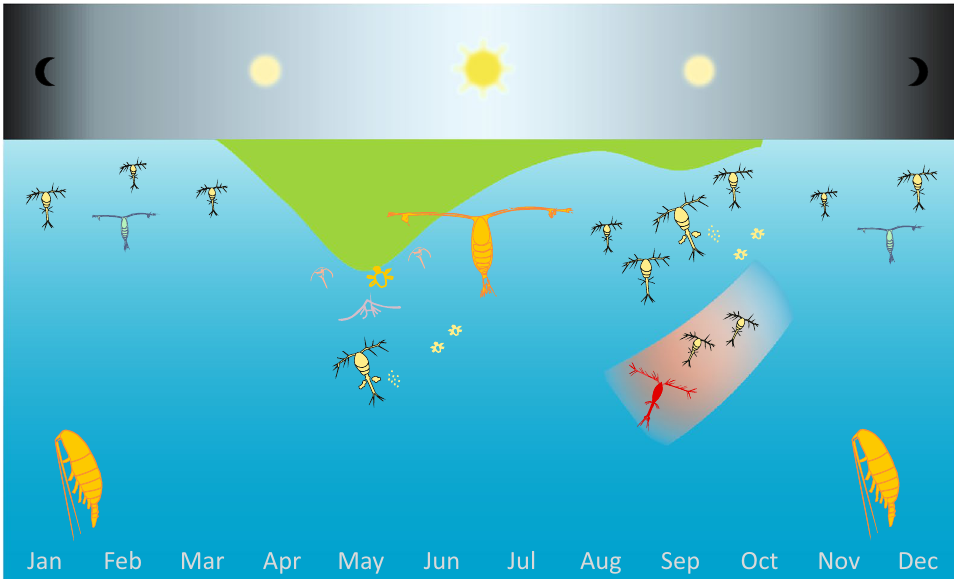
Figure 8. Conceptual figure showing phenology of Oithona similis in heavily Atlantic-influenced high Arctic fjord (Isfjorden). Oithona similis dominate the mesozooplankton community during autumn/winter together with other small copepods (e.g. Pseudocalanus spp.) when larger Calanus species descended in depths for winter diapause. In high-spring and summer it avoids overcrowding by meroplankton and herbivores in the upper water layer by peaking in numbers in September after periods of high primary production utilizing post bloom regenerated production. It is possible that the two main reproduction events per year coincide with the periods of high primary production. The abundance peak in September might result both from local reproduction and also be related to a stronger inflow of Atlantic water carrying the Atlantic indicator species— Oithona atlantica (marked in red) during that